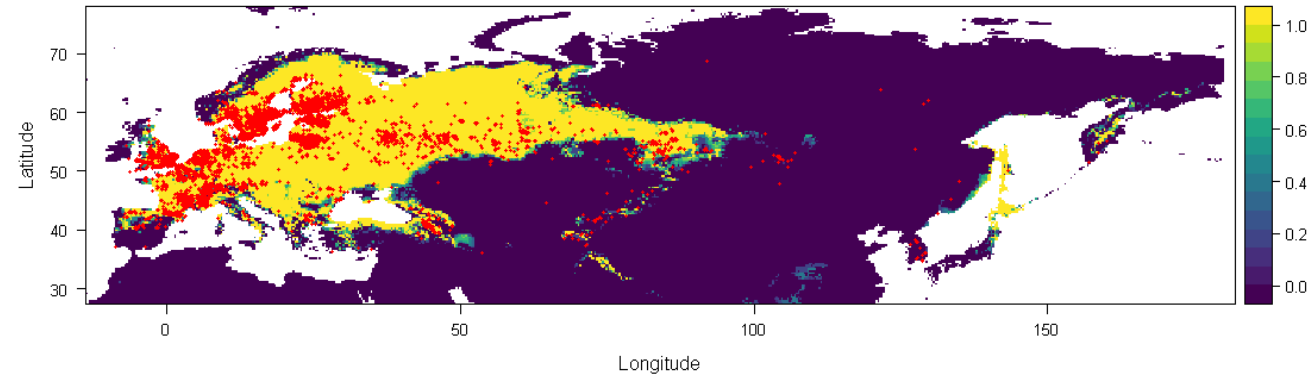
Figure 1. Average prediction of climate habitat suitability maps for Sympetrum flaveolum projected to the present day. Red dots show occurrence records. The probability of occurrence ranges from 0 (dark purple, low probability) to 1 (yellow, highest probability).